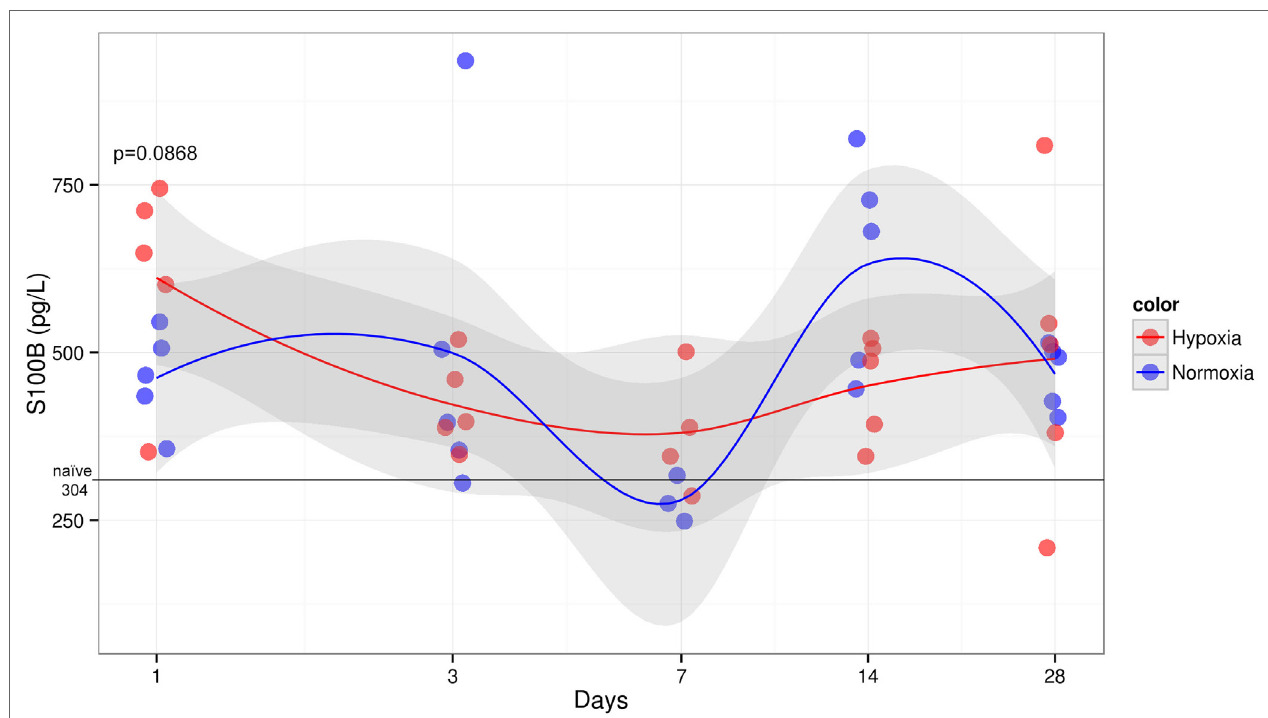
FigUre 7 | serum s100B levels over time after injury . Serum concentration of S100B ( y -axis) measured at different times post-CCI ( x -axis). Black line indicates median naive levels. S100B shows a trend to be significantly elevated in hypoxic compared to normoxic group at 1 day after injury (Student’s t -test p = 0.0868). No other survival time showed any significance or trend between groups, yet levels remained elevated compared to naive rats. No significant temporal trend could be